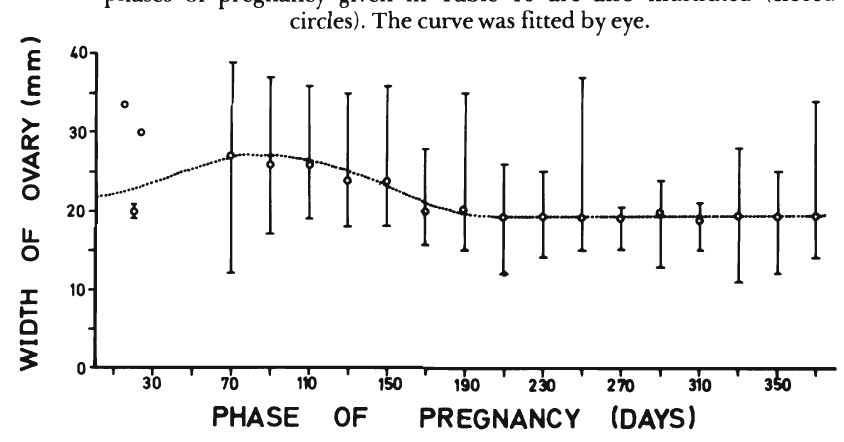
Fig. 10. Width ot Burchell's zebra ovaries (smooth surface to smooth surface) as an index of follicular activity. The open circles give the average width for each of the 19 arbitrary phases of pregnancy given in Table 10 and the vertical lines the total variation of each. The curve was fitted by